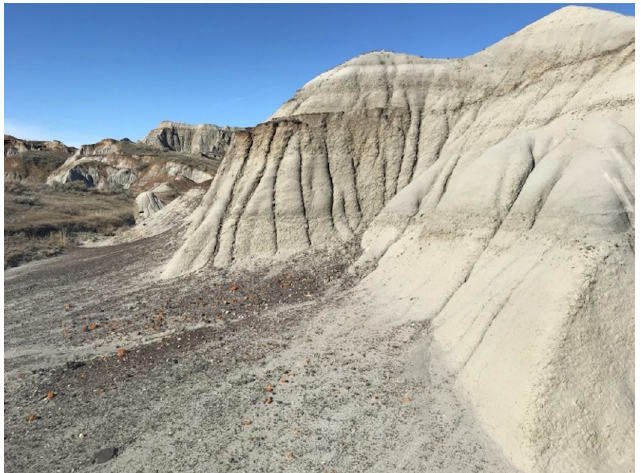
Figure 1. Unexcavated horned dinosaur bone bed in Dinosaur Provincial Park, Alberta, showing predominantly sandstone sediment with a clear layer of ironstone and lichen-encrusted fossils distributed on